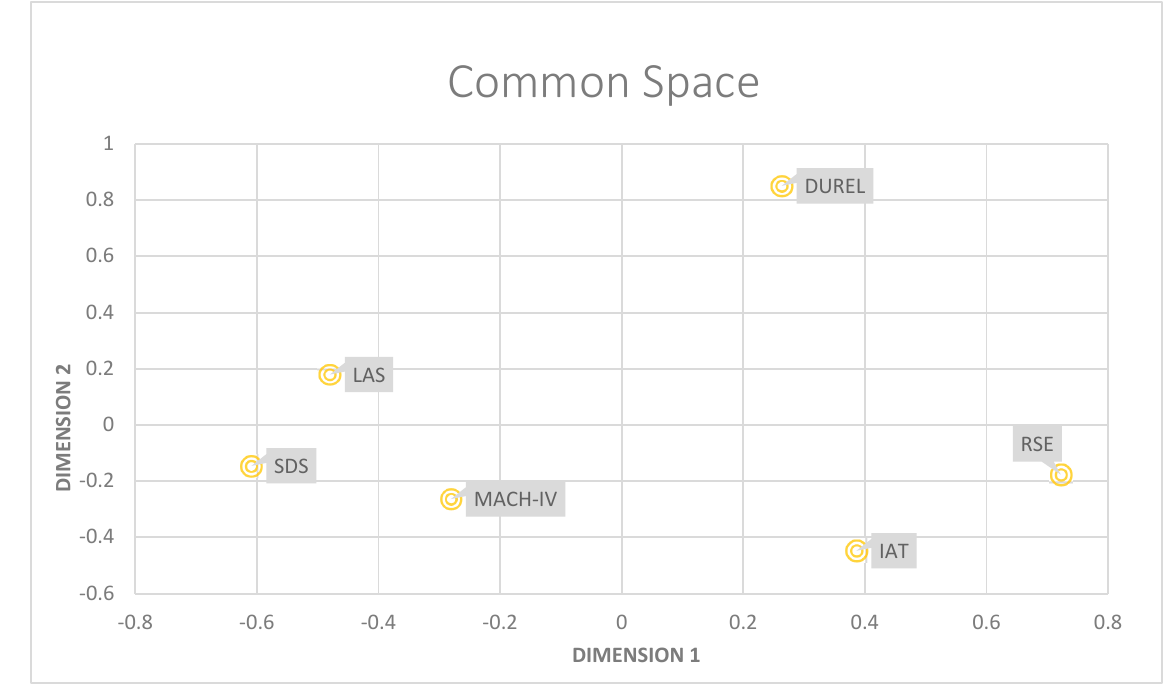
Figure 2. A 2-D scale displaying associated groupings across the six psychometric tests.